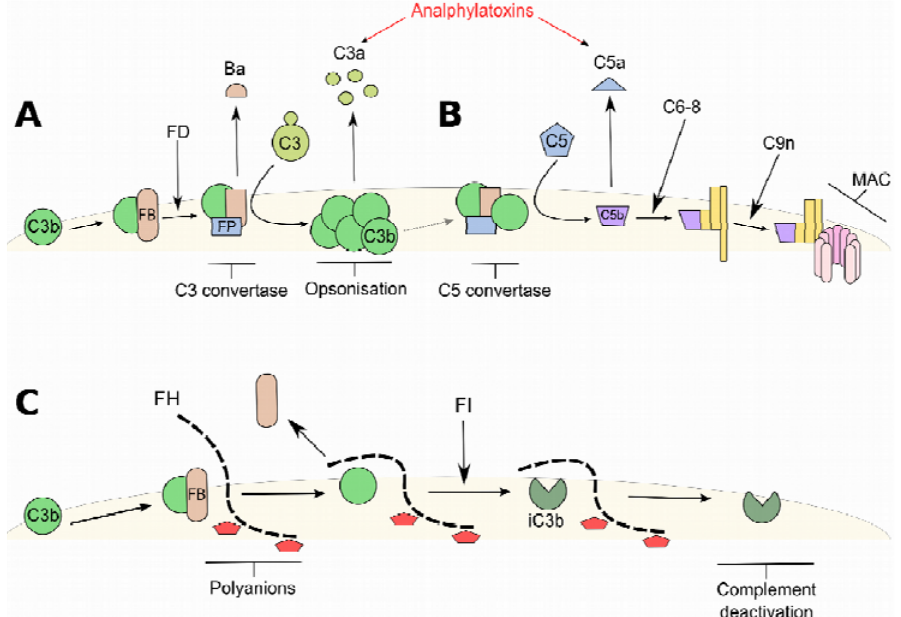
Figure 2. Schematic showing the activation of complement by the alternative